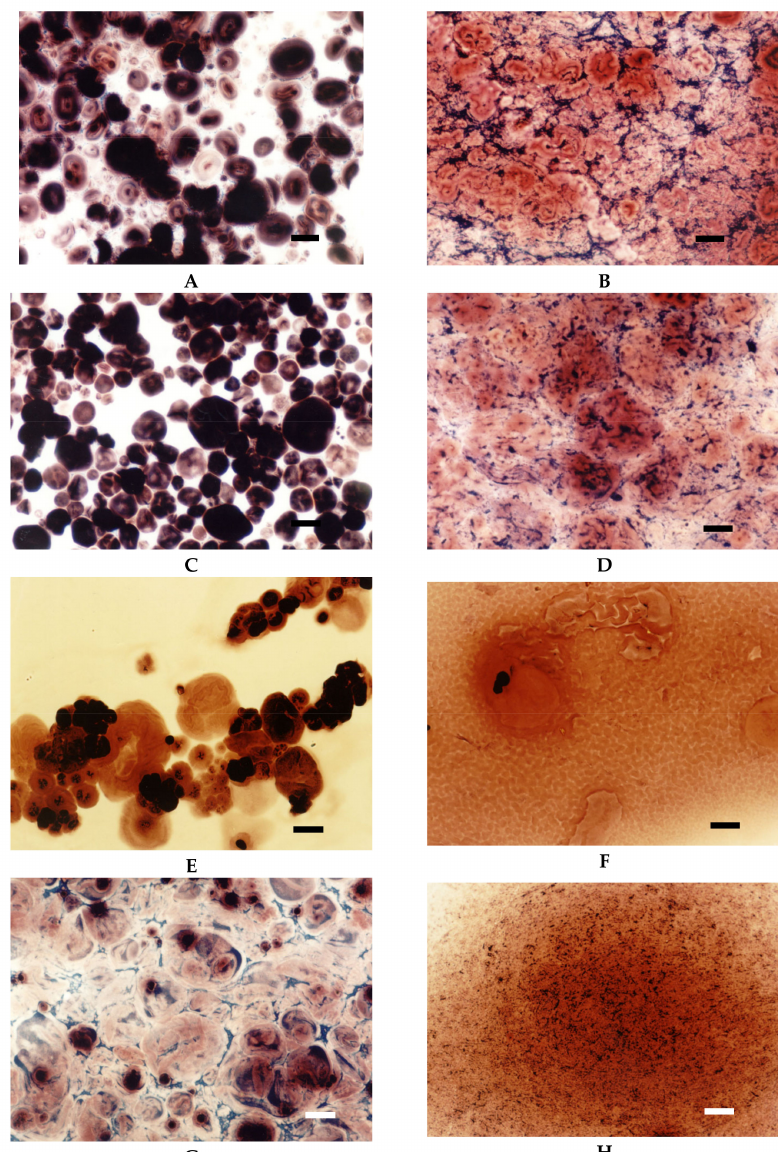
Figure 3. LM micrographs (20 × ) of native starch dispersions incubated at di ff erent temperatures for 15 min: ( A ) Wheat 75 ◦ C, ( B ) Wheat 90 ◦ C, ( C ) Corn 75 ◦ C, ( D ) Corn 90 ◦ C, ( E ) Waxy corn 68 ◦ C, ( F ) Waxy corn 90 ◦ C, ( G ) Tapioca 68 ◦ C, ( H ) Tapioca 90 ◦ C, (Bar-20 µ